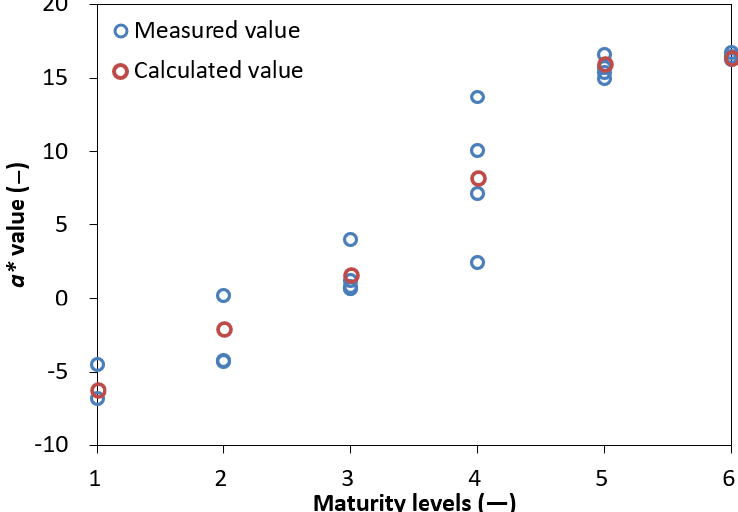
Figure 11. Comparison of the measured a * value through expert classification, and the a * values calculated from images.